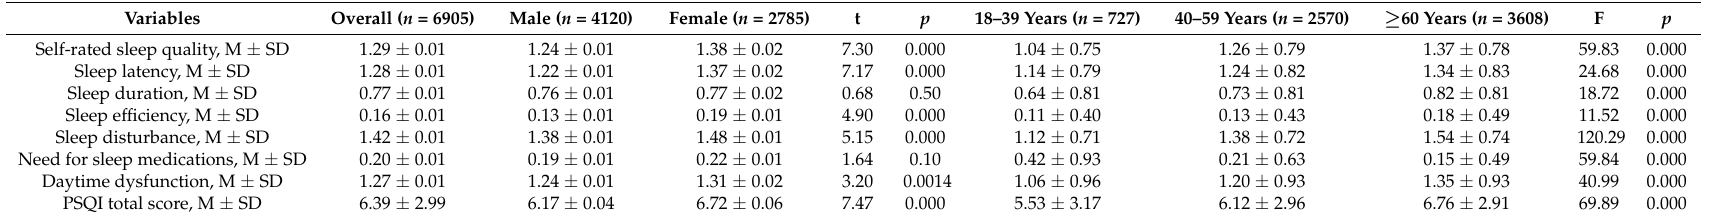
Table 3. Gender and age category scores of PSQI component scores and total score in all